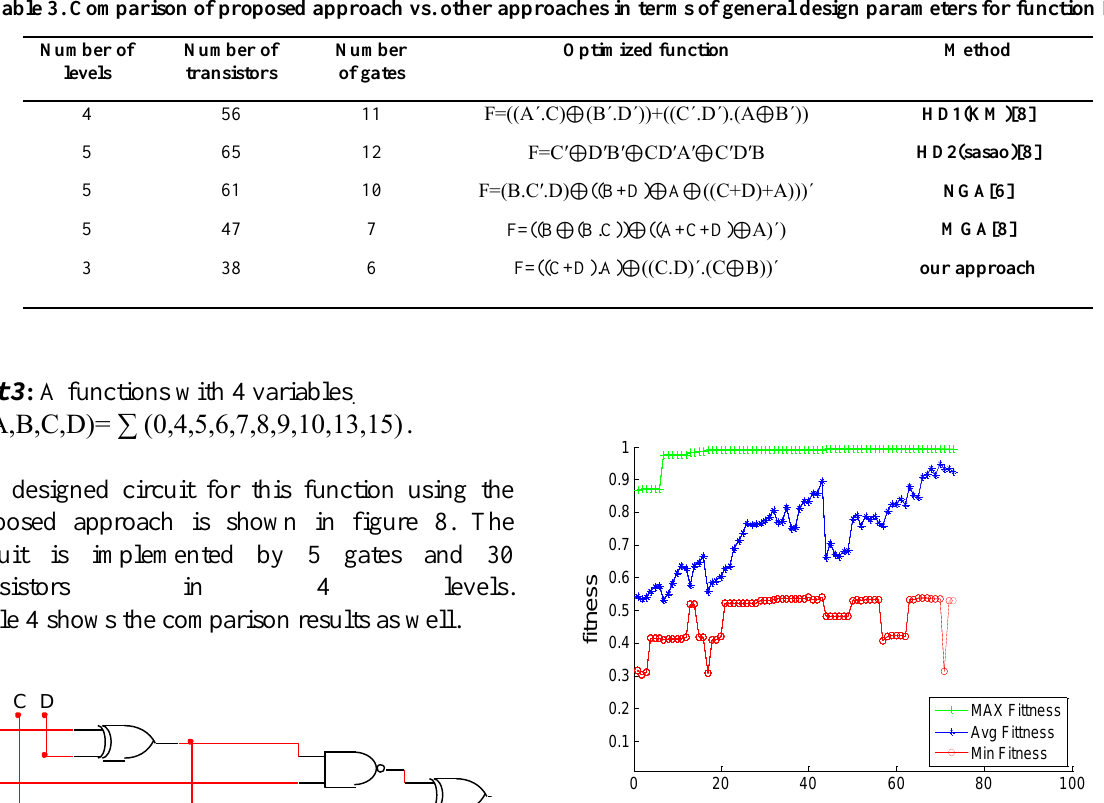
Table 3. Comparison of proposed approach vs. other approaches in terms of general design parameters for function F 2 . Number of Number of transistors levels